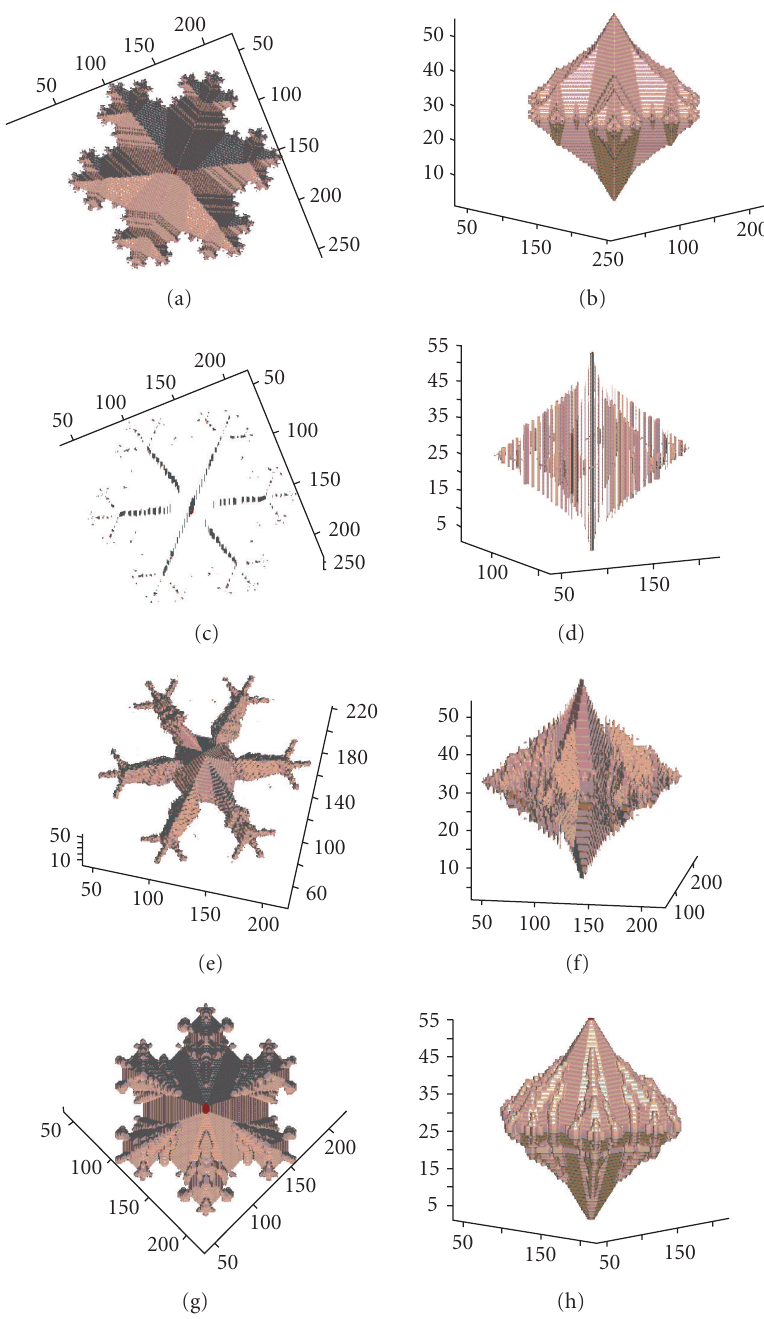
Figure 4.2. Top and side views of (a)-(b) model 3D fractal binary pore, (c)-(d) pore-channel, (e)-(f) pore-throat, and (g)-(h)